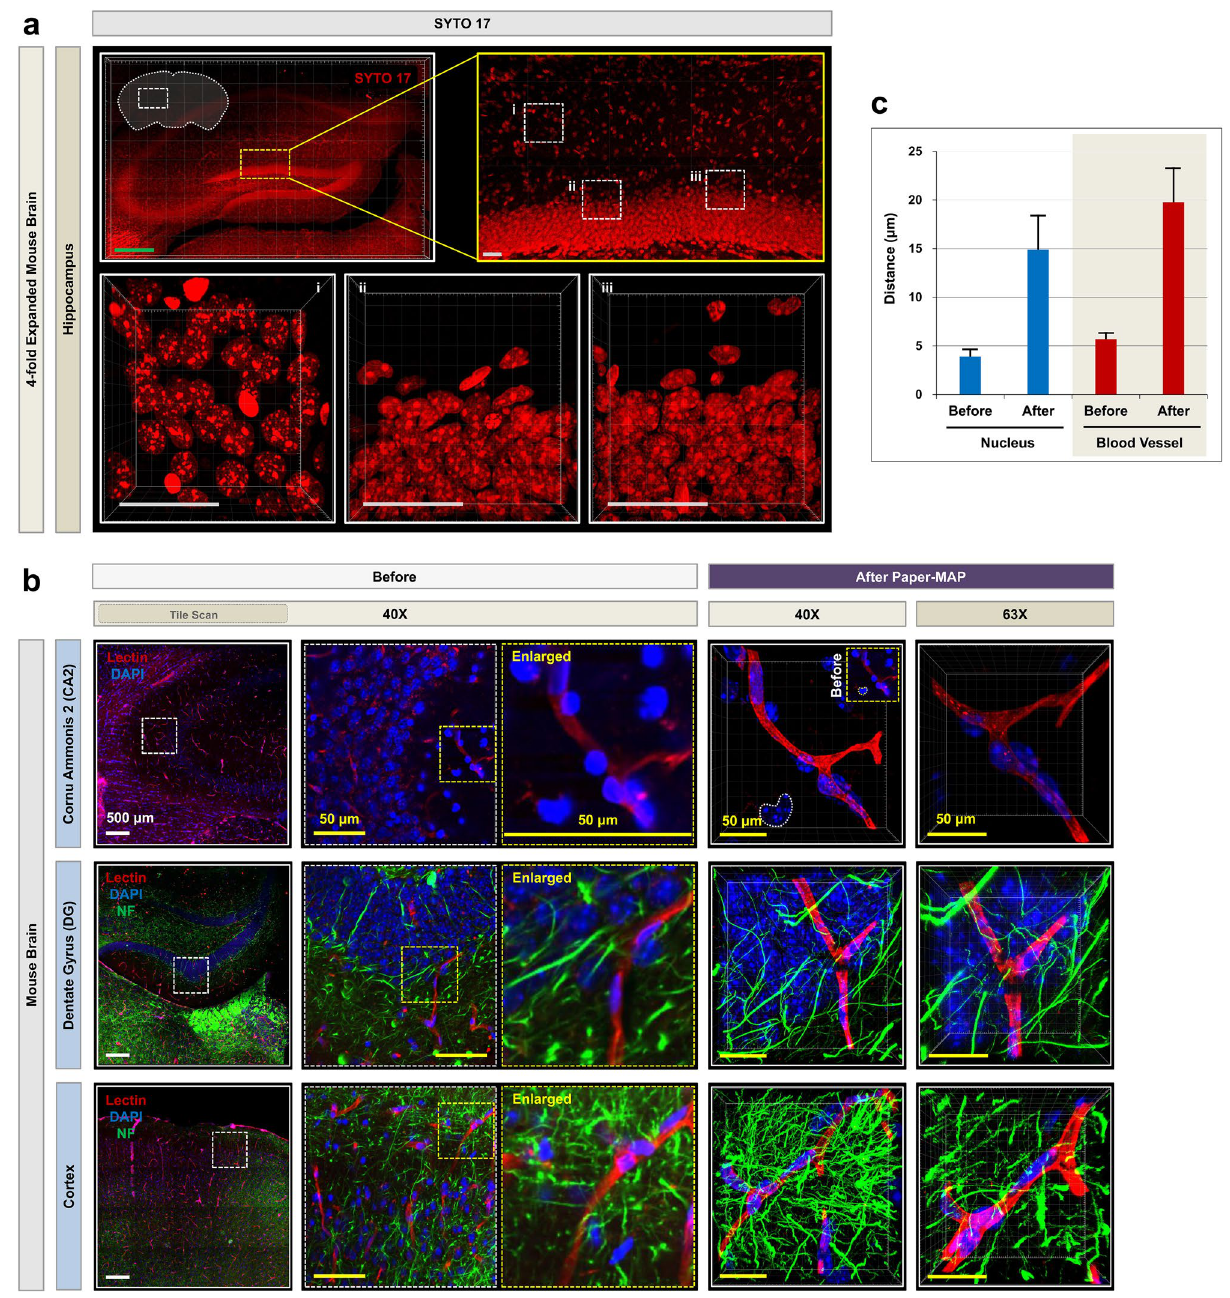
Figure 3. Visualization of vasculature and neural structure in rodent brains via Paper-MAP. ( a ) SYTO-17 immunostaining in the hippocampus of mouse brain sections processed via Paper-MAP, imaged with confocal microscopy (4 × 5 panels, horizontal × vertical tiles). Each image (enlarged; i, ii, and iii) was taken with the same 63 × objective lens and z-stacked (range: 100-μm) for comparison. Scale bars (green, 1000-μm; gray, 100-μm). ( b ) Lectin and neurofilament (NF) immunostaining in the hippocampus and cortex of mouse brain sections processed via Paper-MAP. Each image of before (left; unexpanded mouse brain sections of 4% PFA fixed) was taken with the same 40 × objective lens and single z-images (5 × 5 panels, horizontal × vertical tiles) for comparison. Enlarged images are of each regions (yellow box). Images of after Paper-MAP (right) was taken with the same 40 × and 63 × objective lens and z-stacked (range: 100-μm) for comparison. 3D projection of the blood vessel (lectin, red) and neurofilament (green) focusing on the cortex and hippocampus regions, including the cornu ammonis 2 (CA2), dentate gyrus (DG). Scale bars (white, 500-μm; yellow, 50-μm). ( c ) Quantification of size in nucleus (blue) and blood vessel (red) of the before (unexpanded) and after Paper-MAP in mouse brain. Quantification of total diameter from different ratio combinations. Data are presented as mean ± SD (standard deviation); n = 5 for each experimental group. Illustration of mechanism is visualized by PowerPoint